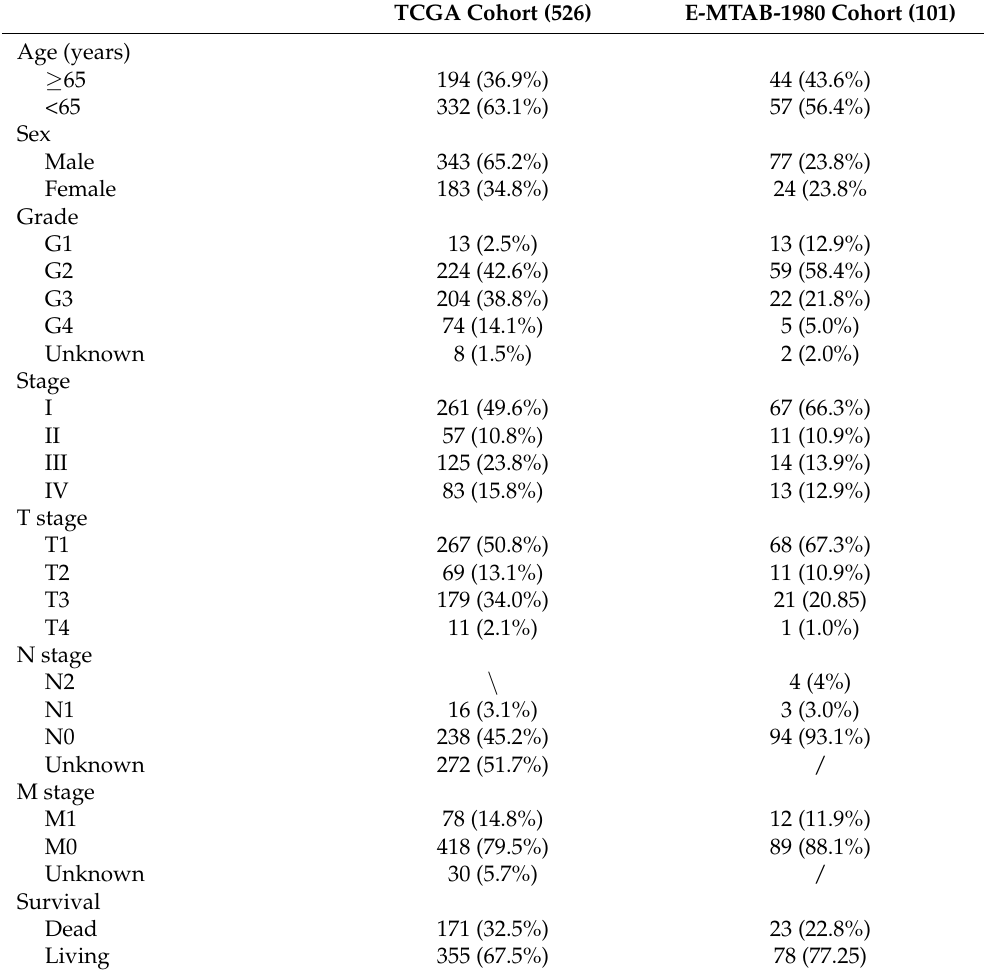
Table 1. Basic clinical characteristics of patients in the TCGA cohort and E-MTAB-1980